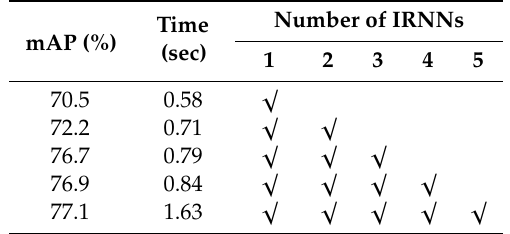
Table 1. Influence of number of IRNNs groups in context feature extraction module on object detection accuracy.